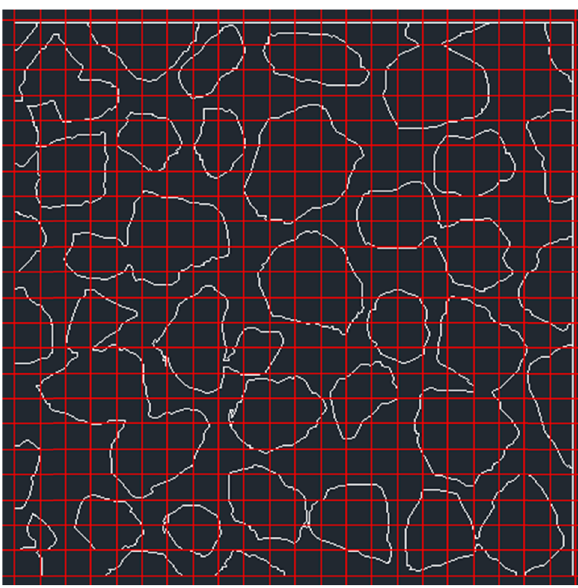
Figure 8: Grid coverage on sand group outline.